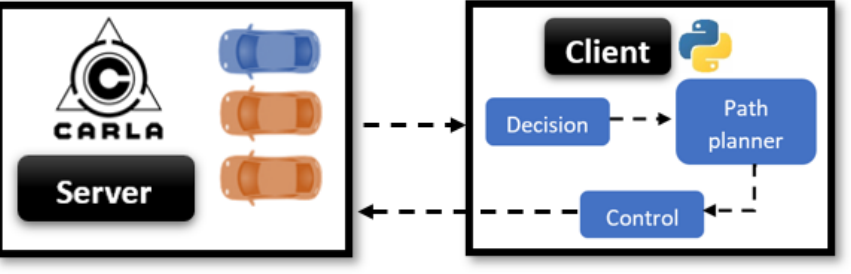
Figure 12. Carla Simulator client/server